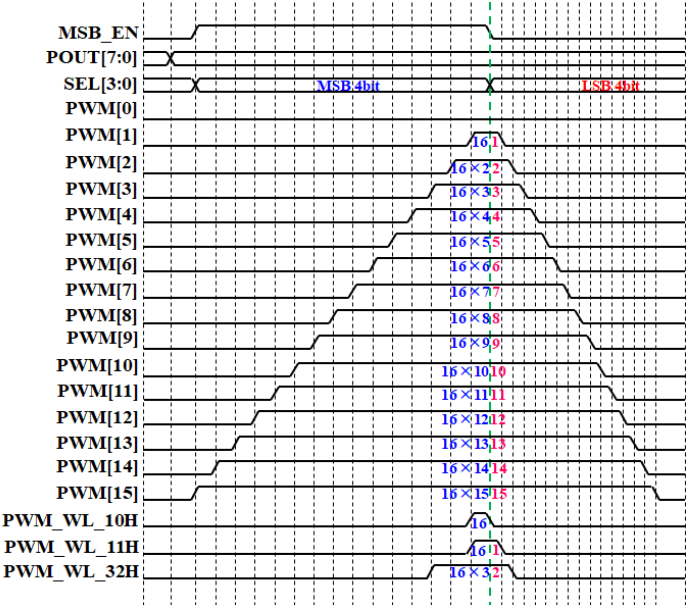
Figure 8. Timing diagram for a two-step PWM conversion.